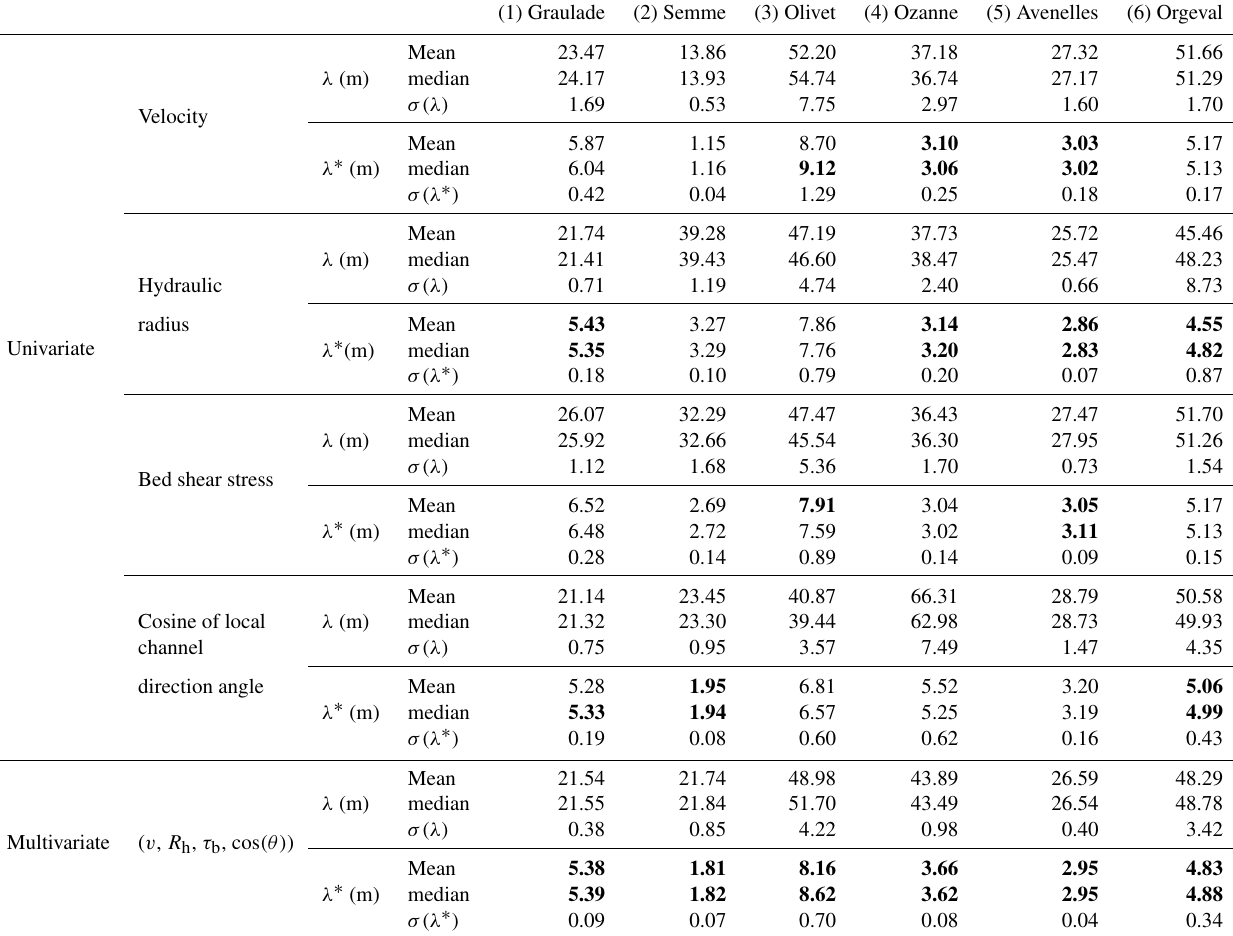
Table 4. Summary of results for all reaches in the univariate case using the velocity, hydraulic radius, bed shear stress, or local channel direction angle and in the multivariate case using all these four variables. For each variable, we compute the mean, median, and standard deviation σ of the wavelength and the longitudinal spacing. This one ( λ ∗ ) is calculated by λ represent the median or the mean wavelengths that are similar in both the univariate case and the multivariate case in a